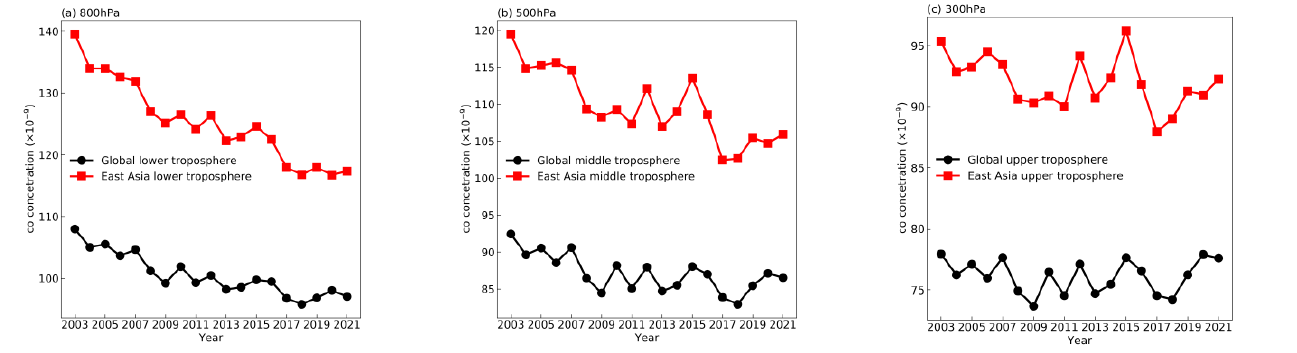
Figure 8. Annual variation curves of different tropospheric pressure layers in East Asia and the world from 2003 to 2021. ( a ) 850 hPa; ( b ) 500 hPa; ( c ) 300 hPa. Table 3. Linear fitting of different pressure layers of CO concentration in East Asia and the world from 2003 to 2020.